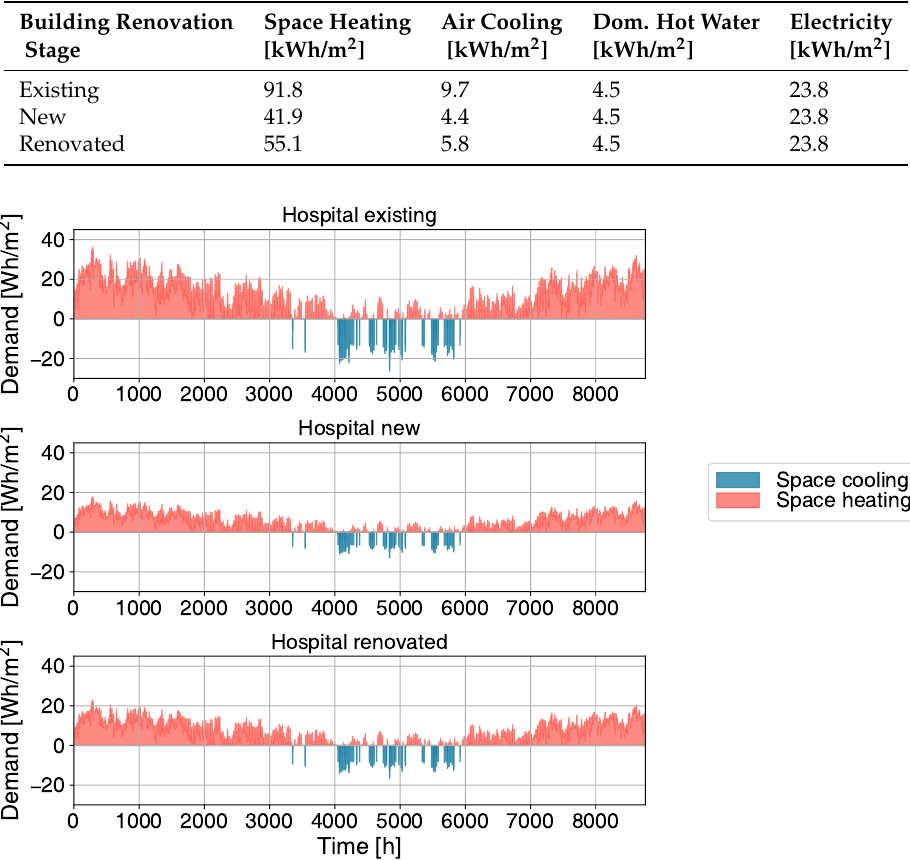
Figure A6. Hourly specific energy service demand of hospital